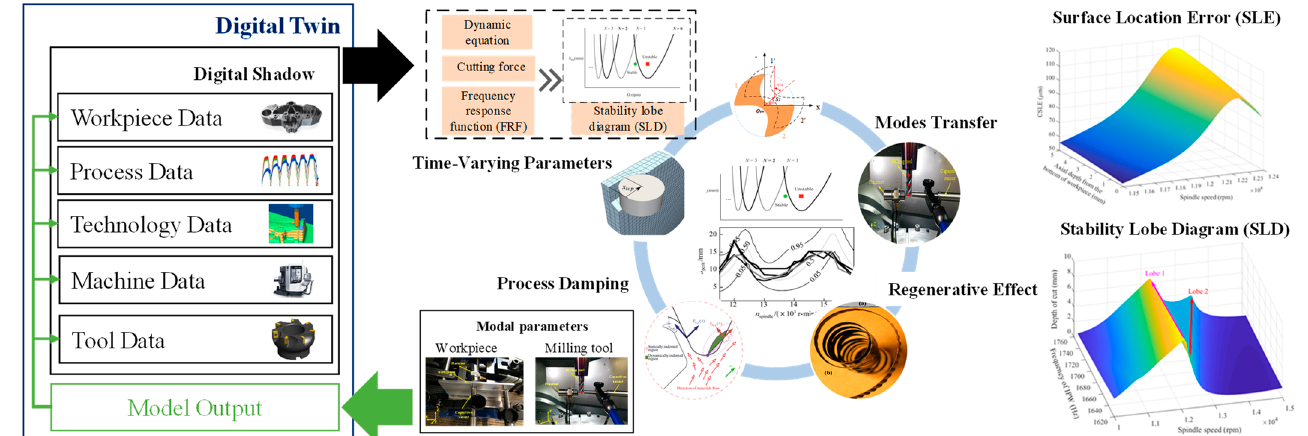
Figure 6. Stability process analysis using a digital twin.